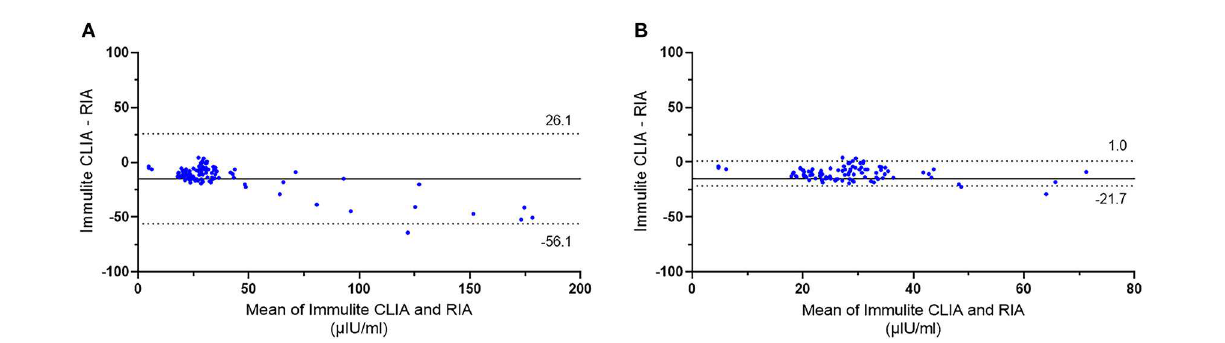
FIGURE4 Bland–Altman plot showing agreement between insulin concentrations ( µ IU/ml) in equine serum samples measured with Immulite ® 1000 CLIA and RIA. (A) All samples ( n = 106) and (B) samples with RIA < 100 µ IU/ml ( n = 95). The solid line indicates the bias, and the dotted lines indicate the 95% limits of agreement.